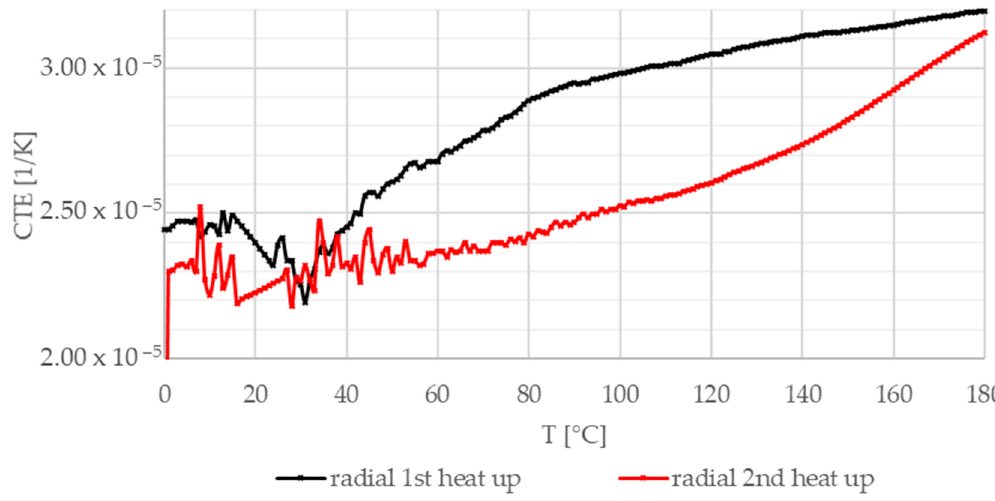
Figure 16. Coe ffi cient of thermal expansion—radial direction, two heat-up loops (black, red). Materials 2020 , 13 , x FOR PEER REVIEW Figure 16. Coefficient of thermal expansion—radial direction, two heat-up loops (black, red).